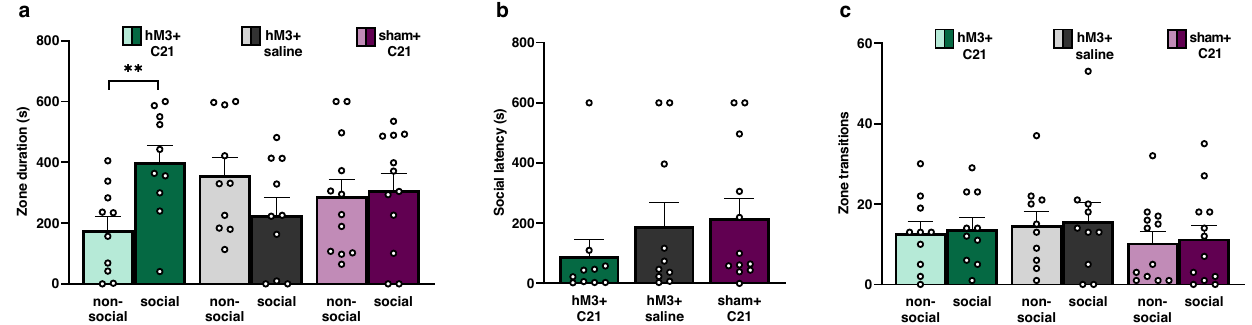
Fig. 2 LS activation promotes sex naïve social approach. a Duration (s, seconds) of time spent in the non-social (light color bars) and social zones (dark color bars) of the social approach test apparatus by hM3 + C21, hM3 + saline, and sham + C21 subjects. b Latency to approach (s) stimulus animal by hM3 + C21, hM3 + saline, and sham + C21 subjects. c Frequency of zone transitions between non-social (light color bars) and social zones (dark color bars) by hM3 + C21 (green bars), hM3 + saline (gray bars), and sham + C21 (purple bars) subjects. Data are presented as mean ± SEM. Dots represent individual data for hM3 + C21 ( n = 10), hM3 + saline ( n = 10), and sham + C21 ( n = 12) subjects. ** p < 0.01.